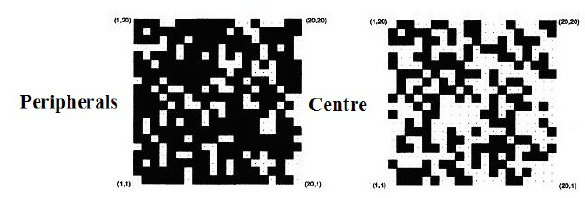
Fig. 5. Mosaic model of the center and periphery of the sinoatrial node. The lattice dimension is 20x20. The total number of nodal and atrial cells is 400. Nodal cells are shown in white squares, atrial cells in black. a) mosaic model of the periphery, b) the central part of the